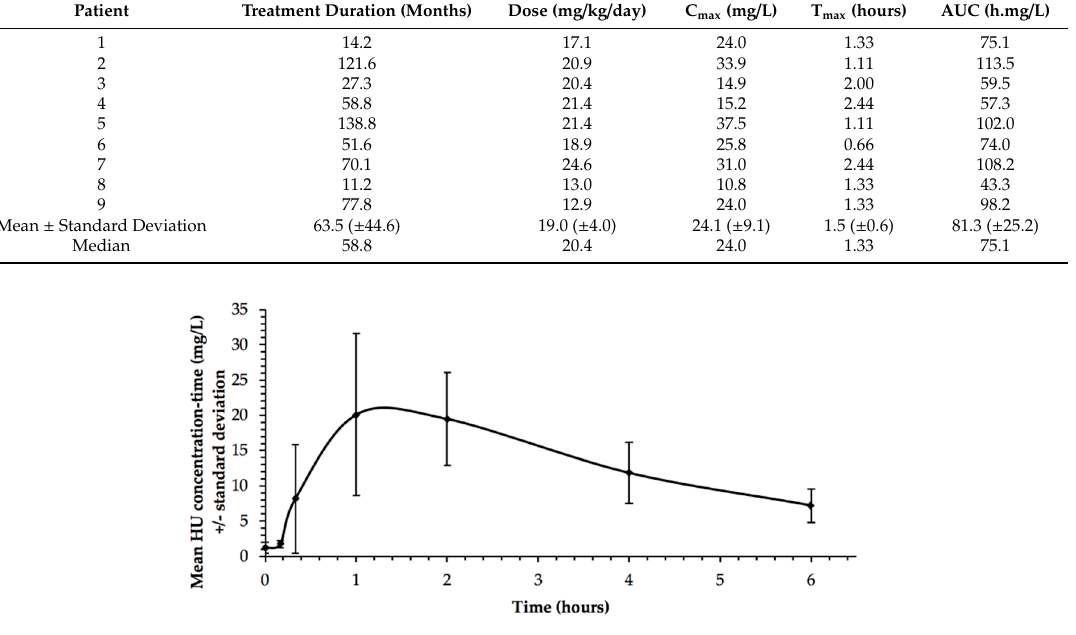
Figure 1. Mean HU ( ± standard deviation) concentration–time plot ( n = 9 Figure 1. Mean HU (± standard deviation) concentration–time plot ( n = 9 patients).